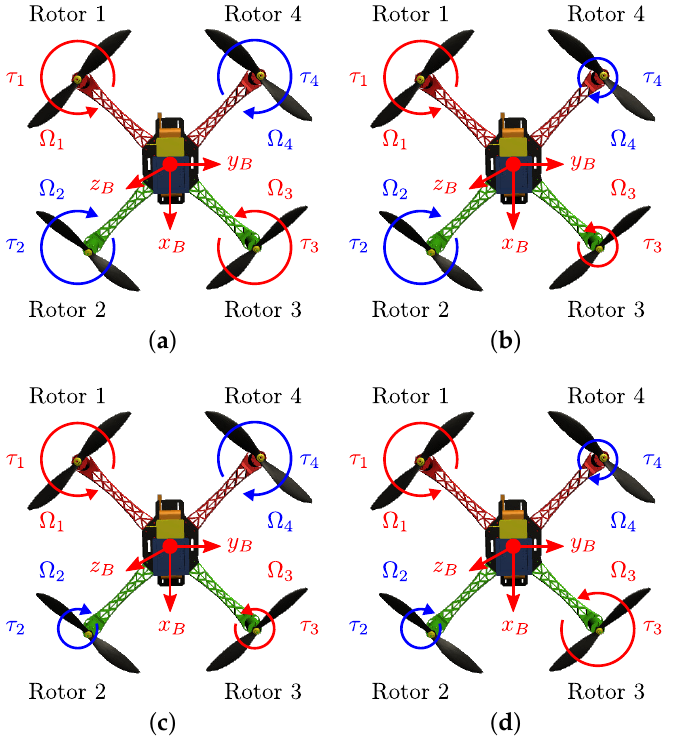
Figure 4. Independent quadrotor motions. ( a ) Vertical thrust. ( b ) Roll motion. ( c ) Pitch motion. ( d ) Yaw